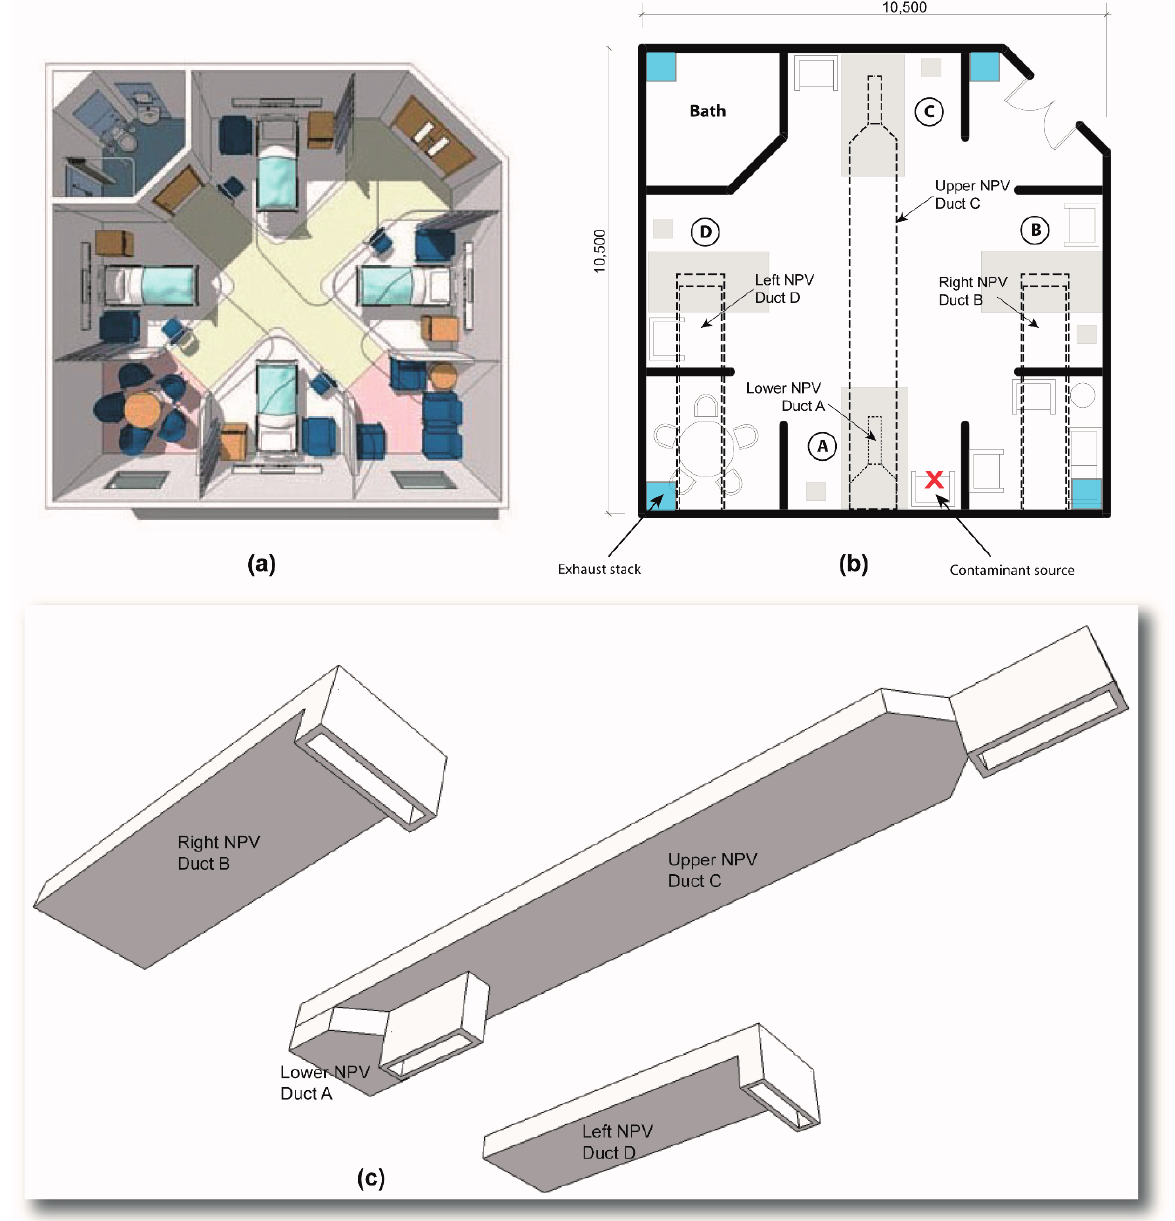
Figure 9. Design of original Cruciform ward © Nightingale Associates showing: ( a ) Top view; ( b ) NPV ducts fitted in plan; ( c ) Vertical air channel for NPV ducts in 3D orientation over four